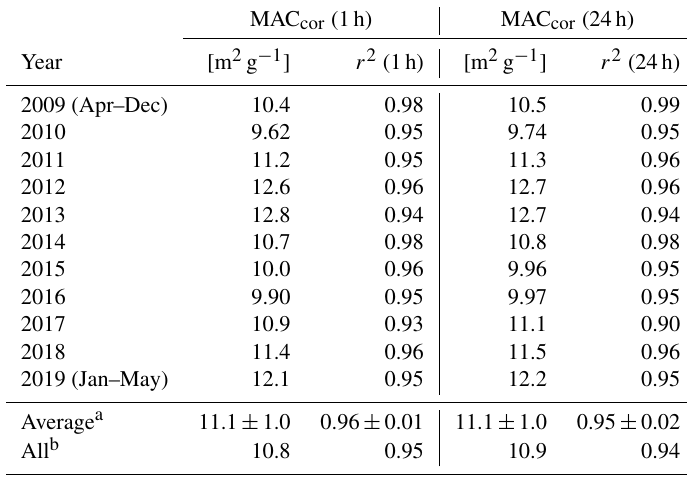
Table 10. Year-to-year variability of MAC cor (MAAP; λ = 639nm) and r 2 at